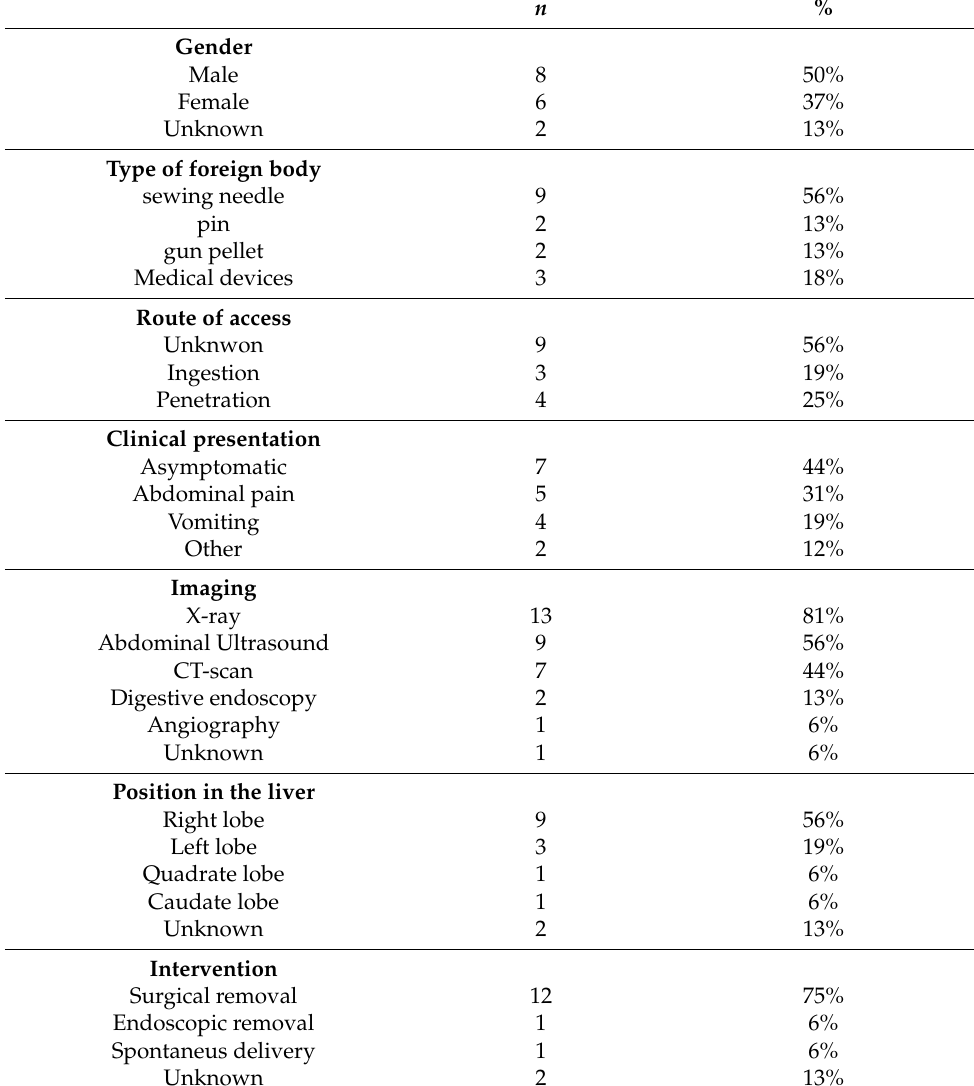
Table 2. Patients demographics and clinical